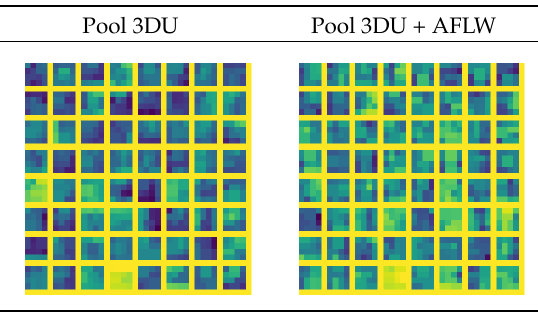
Table 4. Representation of the last layer of max-pooling from VainillaCNN.